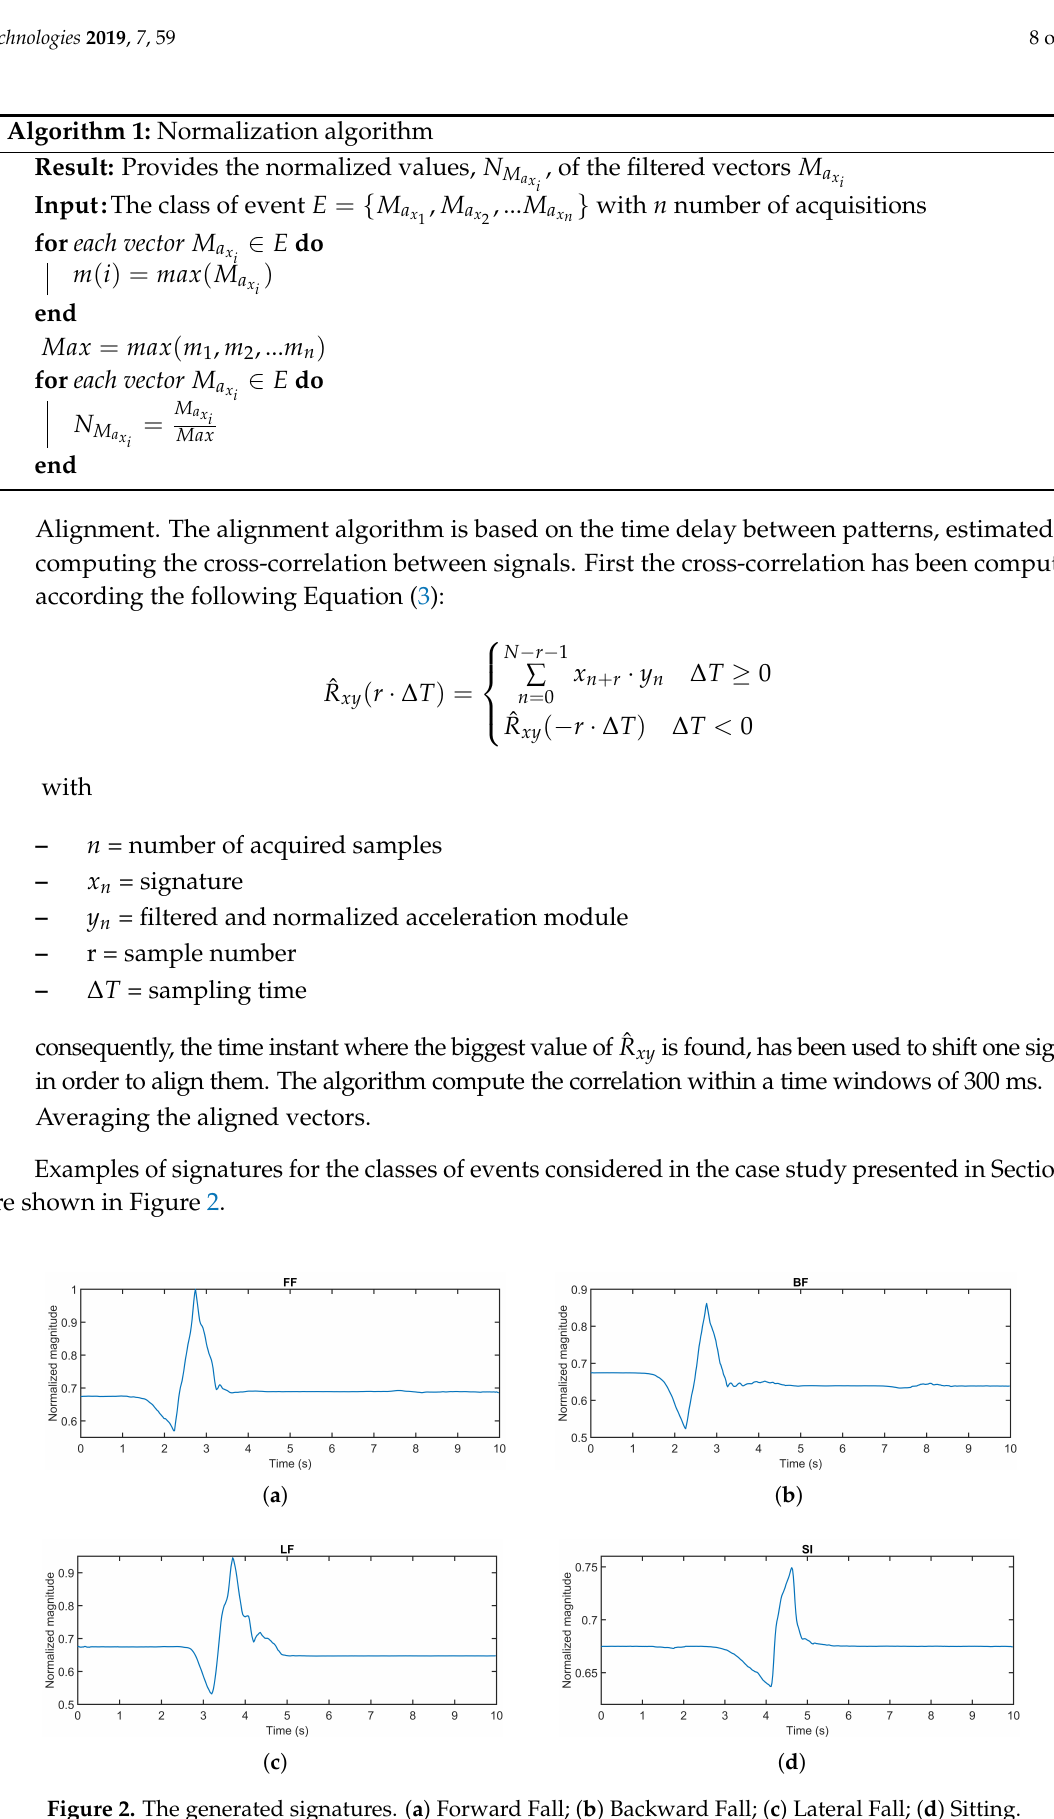
Figure 2. The generated signatures. ( a ) Forward Fall; ( b ) Backward Fall; ( c ) Lateral Fall; ( d )